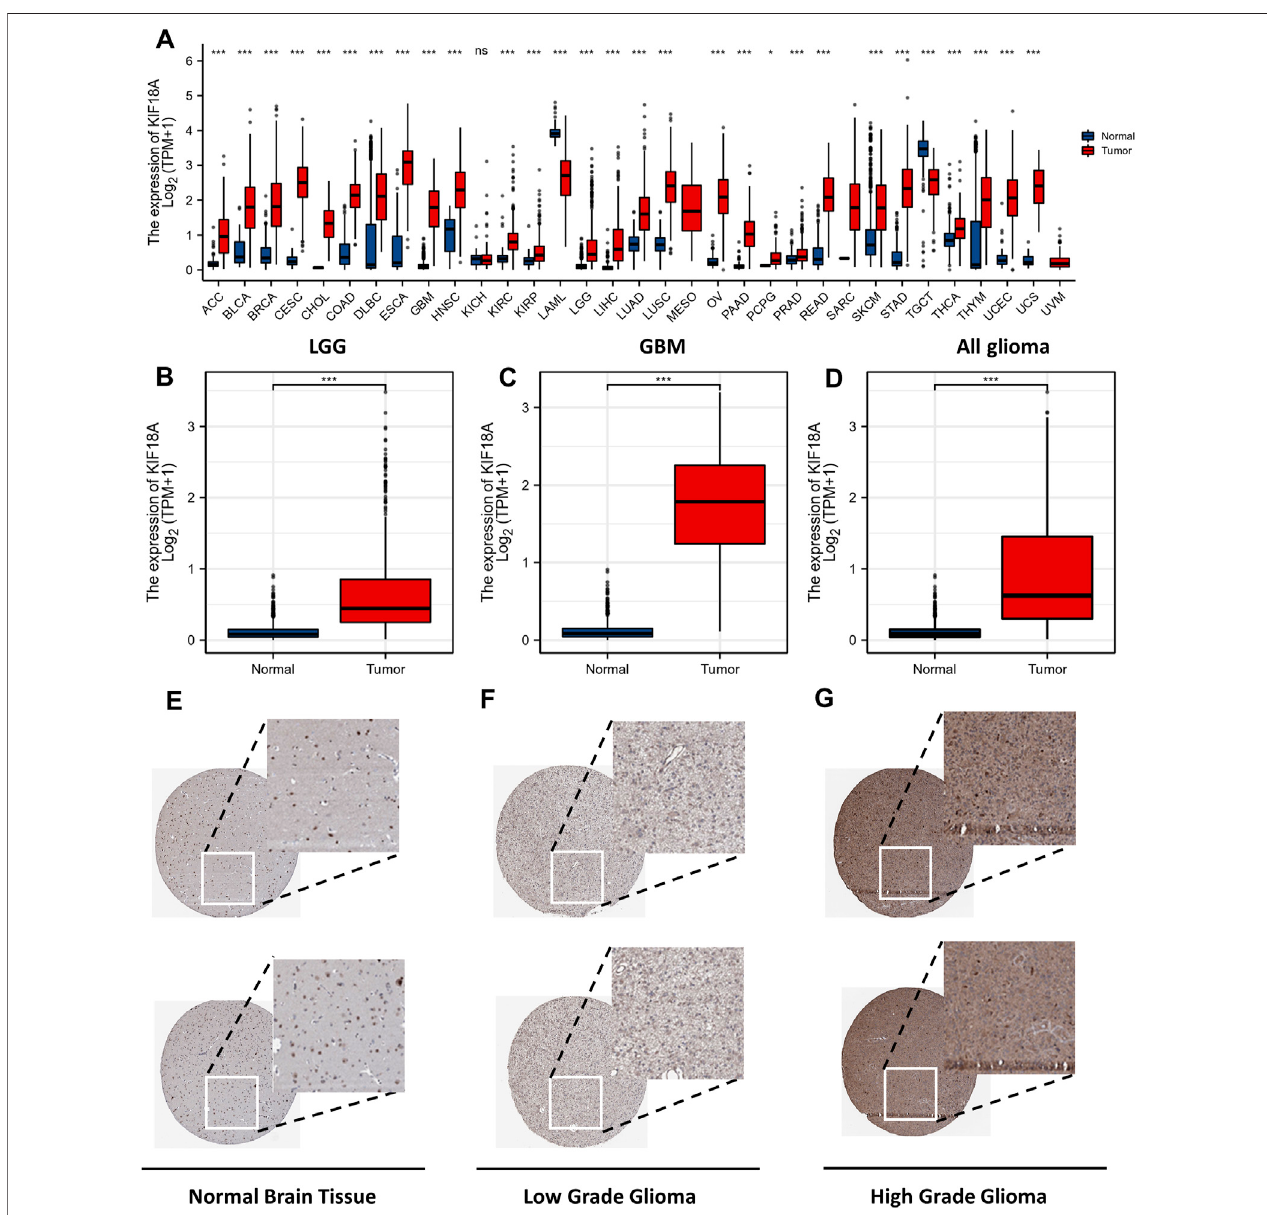
FIGURE 1 | KIF18A mRNA expression level in tumours and normal tissue. The mRNA expression level of KIF18A in (A) different tumour types, (B) LGG, (C) GBM, (D) All glioma was investigated with TCGA database. Cerebral expression of KIF18A protein in Normal Brain Tissue (E) , Low Grade Glioma (F) , High Grade Glioma (G) was visualized using immunohistochemistry via the HPA. (ns, p ≥ 0.05; * p < 0.05, ** p < 0.01, *** p <